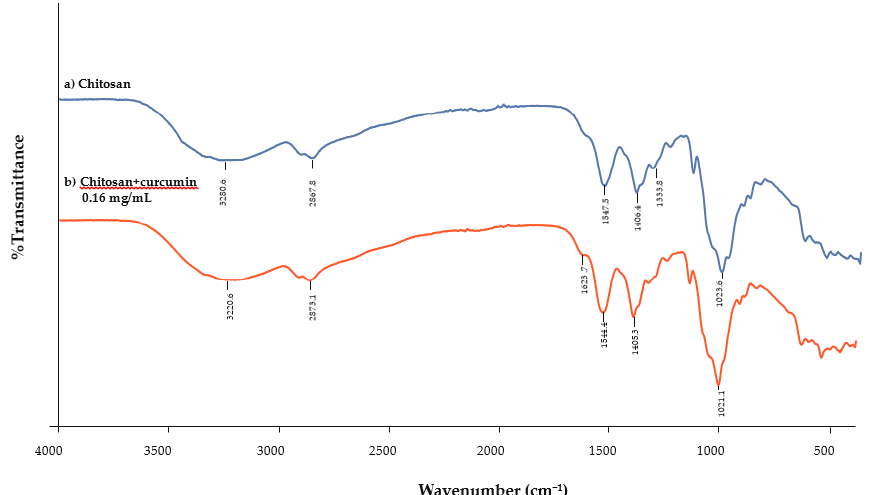
Figure 7. Infrared spectra of ( a ) chitosan films and ( b ) chitosan films incorporated with curcumin extract (0.16 mg/mL).